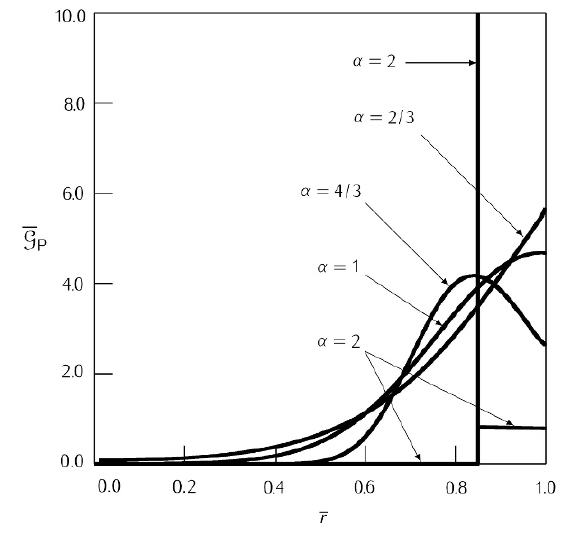
on radial coordinate for H = 0 . 2 , κ = 0 . 15 P